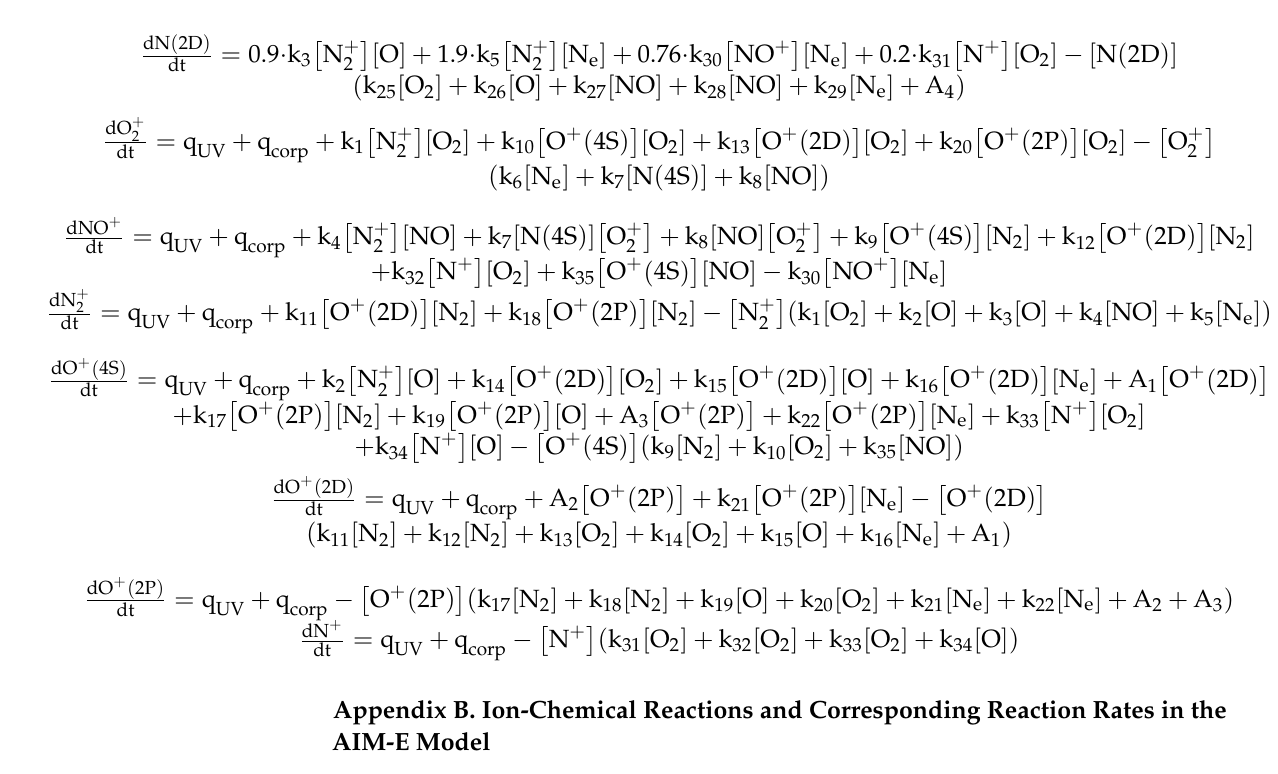
Table A1. Ion-chemical reactions and corresponding reaction rates in the AIM-E model.